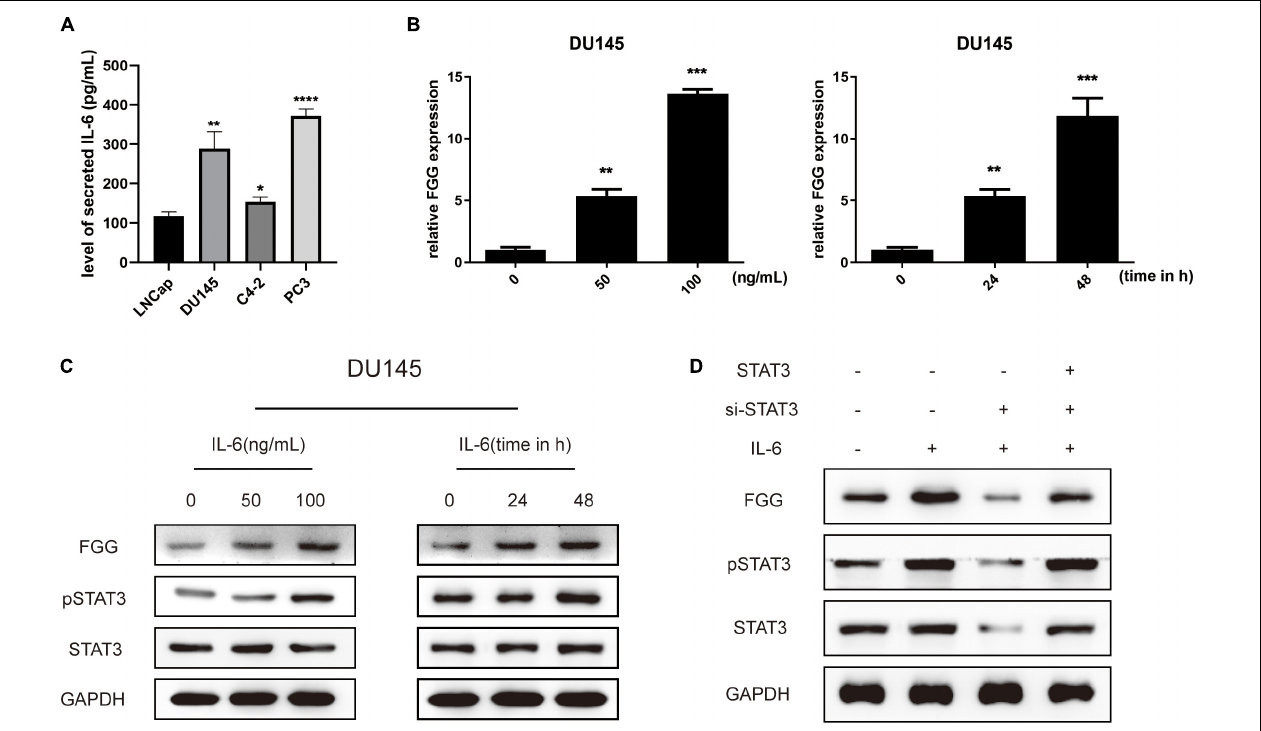
FIGURE 7 | Elevated fibrinogen following ADT is mediated by the IL-6/STAT3 pathway. (A) Level of secreted IL-6 in PCa cell lines. (B) Relative FGG mRNA expression levels 48 h after treatment with 0, 50, or 100 ng/mL of IL-6, and also at 0, 24, and 48 h after treatment with 100 ng/mL of IL-6. (C) Relative protein levels of FGG, pSTAT3, and STAT3 48 h after treatment with 0, 50 or 100 ng/mL of IL-6, and also at 0, 24, and 48 h after treatment with 100 ng/mL of IL-6. (D) Relative protein expression levels of FGG, pSTAT3, and STAT3 after addition of IL-6, si-STAT3, or exogenous STAT3. * p < 0.05, ** p < 0.01, *** p < 0.001, **** p <